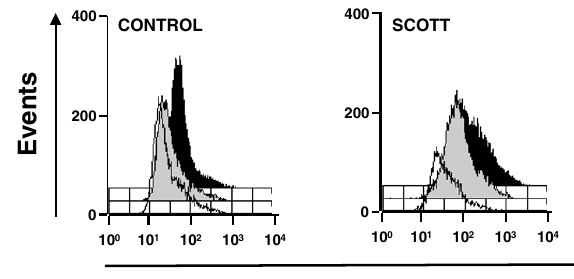
Figure 5 Calcium ionophore and SKF 96365-induced apoptosis of control and Scott B lymphoblasts, assessed by TUNEL and flow cytometry. Control and Scott lymphoblasts were treated with A23187 (200 nM, gray) or SKF 96365 (10 µ M, black) for 48 h, and then stained for DNA fragmentation by TUNEL as described in the "Experimental Procedures". Fluo- rescence shifts observed with A23187 or SKF 96365 treat- ment were compared to those obtained with non-treated cells (empty). Results were reproduced in at least 3 different